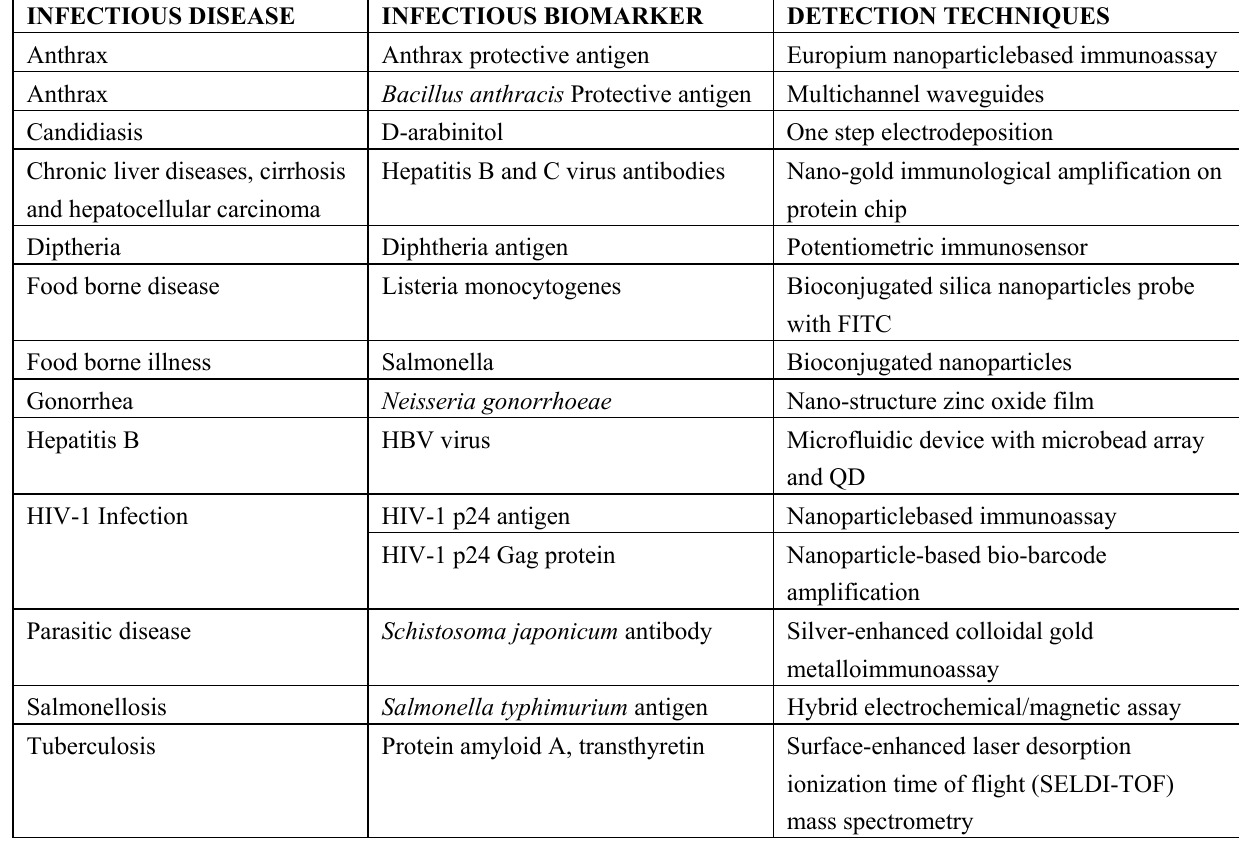
Table 3. A list of infectious biomarkers detected by novel sensors based on nanoproteomics